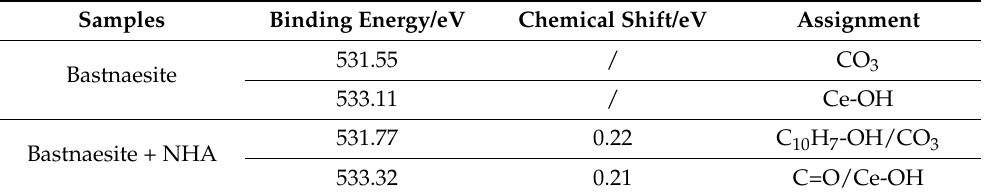
Table 8. Analysis results of O 1 s XPS spectra of bastnaesite samples untreated and treated with